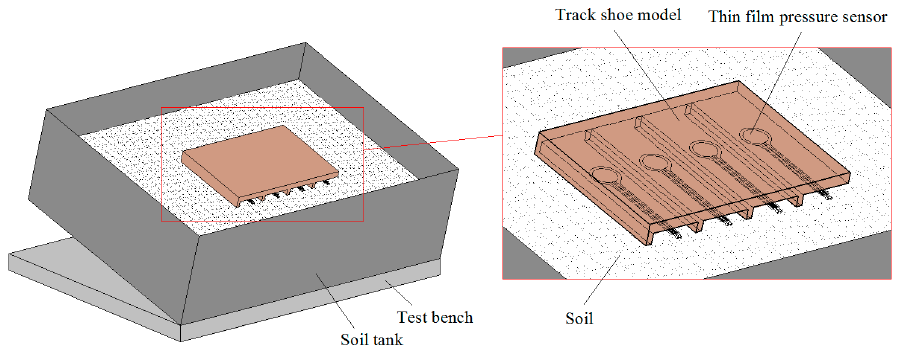
Figure 14. Status of the track shoe model.